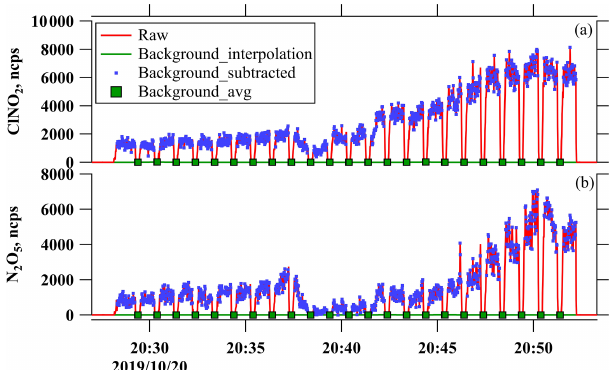
Figure A1. An example of background measurement for N 2 O 5 (a) and ClNO 2 (b) on 20 October